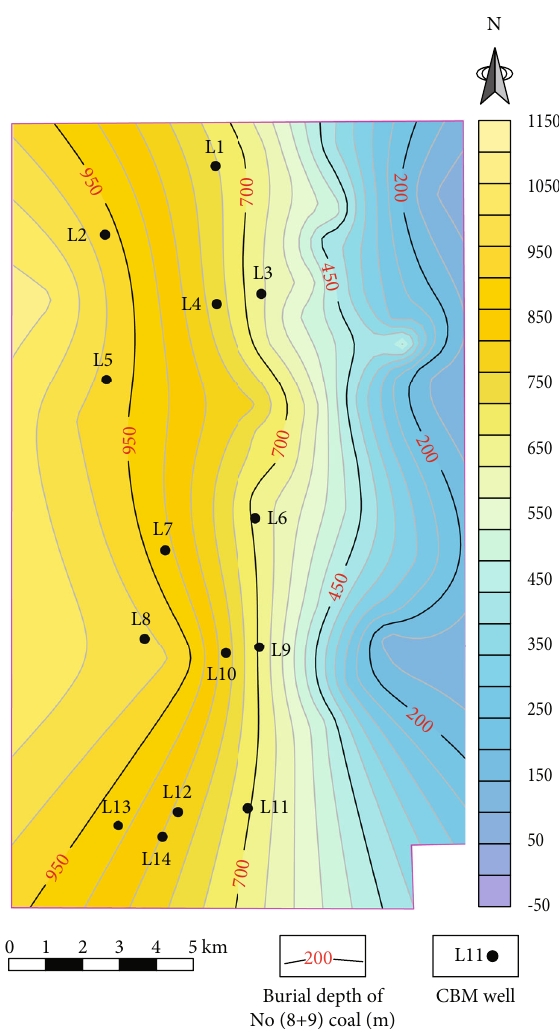
Figure 4: Contour map of coal thickness of No. ( 8 + 9 ) coal in Yangjiapo block.